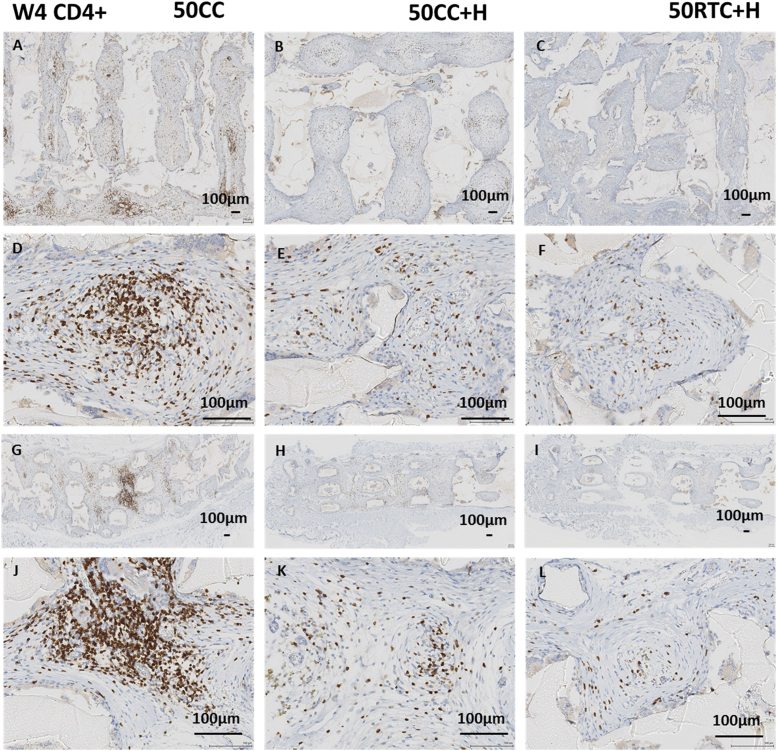
Immunohistochemistry of the host T lymphocyte response towards scaffolds in vivo at week 4. Tissue integration of middle-in-plane (A-F) and cross-sectional view (G-L) of the scaffolds by CD4 (T lymphocyte marker) staining at (A-C, G-I) ×4 and (D-F, J-L) ×20 magnifications.